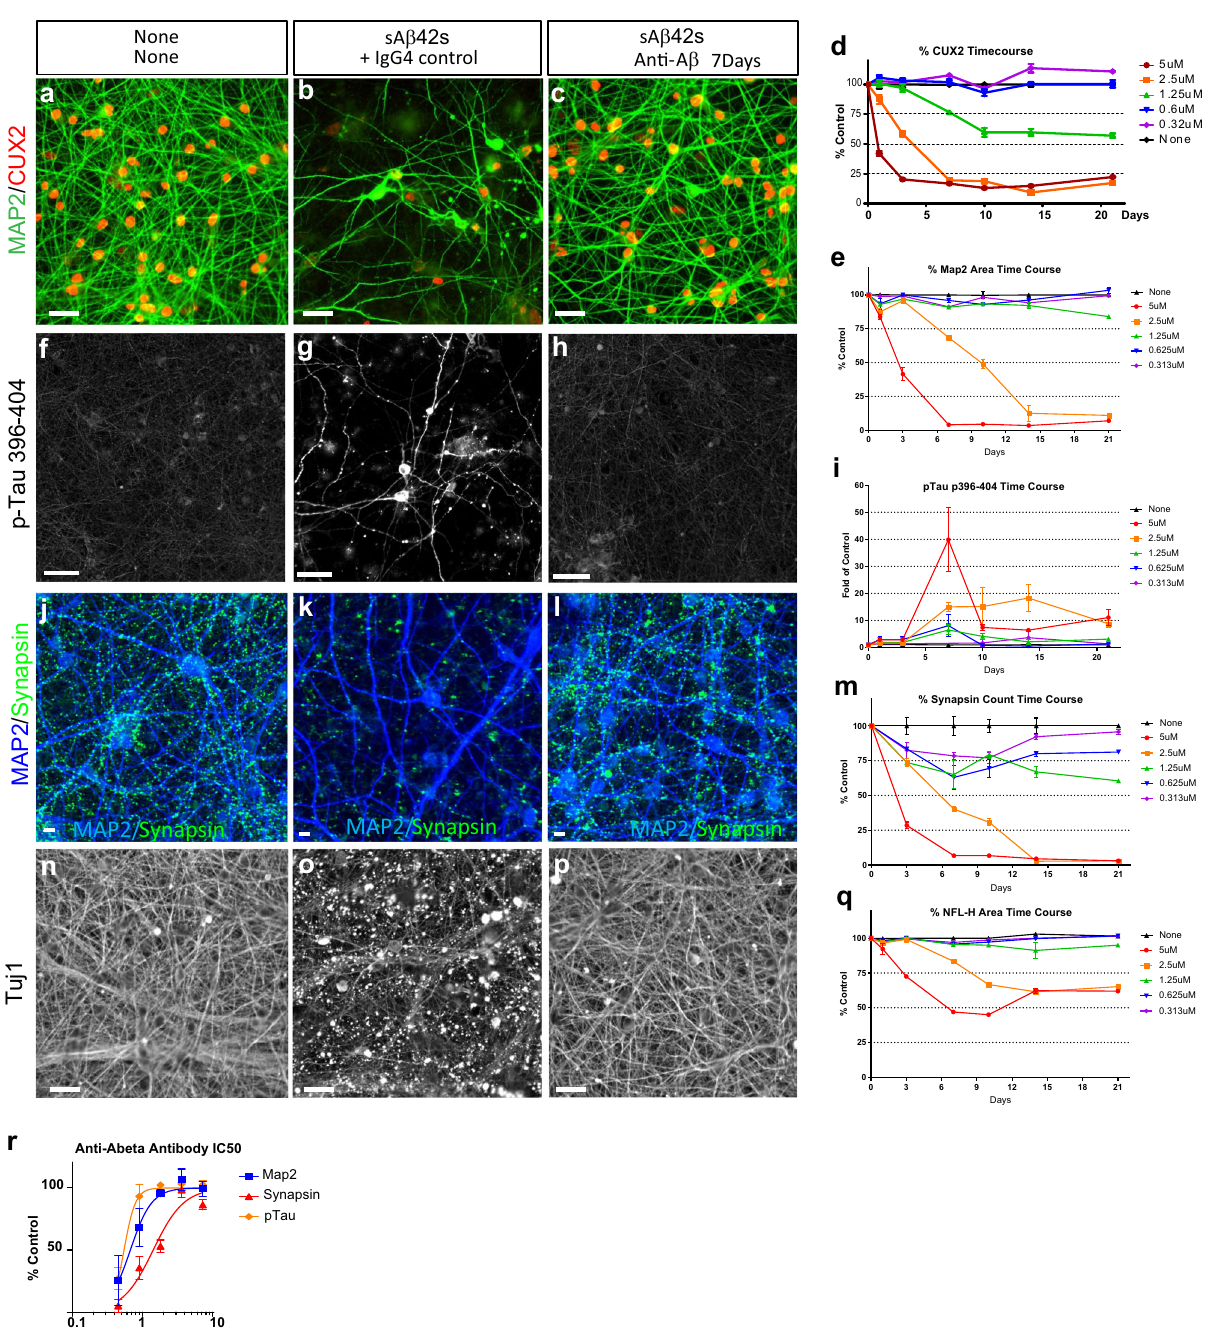
Fig. 2 Human iPSC-derived neuronal model of Alzheimer ’ s disease recapitulates key hallmark AD pathologies. a , b Differentiated NAG neurons (12 weeks + ) show loss of dendrites (MAP2, green) and cell bodies (CUX2, red) when treated with soluble A β species for 7 days ( b ) in comparison to no treatment condition ( a ). c Anti-A β antibody co-treatment with soluble A β species blocks A β -induced cell death. Scale bar 50 μ m. d Dose-dependent, progressive cell death as quanti fi ed by the percentage of cell body (CUX2) numbers in A β -treated normalized to untreated control. e Dose-dependent, progressive dendritic (MAP2) loss as quanti fi ed by the percentage of MAP2 area in A β -treated normalized to untreated control. f , g A β 42 treatment induces phosphorylation of Tau (p-Tau 396 – 404, white) and mislocalization to the cell body. h Anti-A β antibody co-treatment with sA β 42s blocks A β - induced Tau hyperphosphorylation. Scale bar 50 μ m. i Dose-dependent and time course of phosphorylation of Tau at S396/404. Phospho-Tau induced increase at 5 µ M A β treatment before decrease associated with cell death occurred as quanti fi ed by fold p-Tau 396/404 staining in A β -treated normalized to untreated control. j , k A β 42 treatment causes synapse loss in neurons (synapsin, green). l Anti-A β antibody co-treatment with sA β 42s blocks synapse loss phenotype. Scale bar = 5 μ m. m Dose – response and time course of synapse (synapsin 1/2) loss in A β -treated culture normalized to untreated control. n , o sA β 42s treatment induces axon fragmentation (beta-3 tubulin Tuj1, white). p Anti-A β antibody co-treatment blocks axon fragmentation. Scale bar = 50 μ m. q Dose – response and time course of axon fragmentation as quanti fi ed by percentage of the axon (NFL-H) area in A β -treated normalized to untreated control. r Anti-A β antibody rescues all three markers in a dose-dependent manner and IC50 curves can be drawn and calculated (IC50 curve fi tted by Prism software). Data are presented as mean values + / − SEM and n = 4 wells. All scale bars = 50 μ